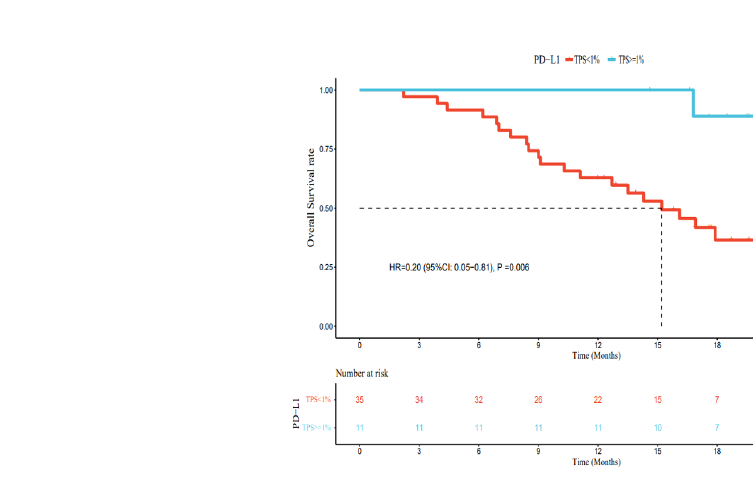
FIGURE 7 The relationship between PD-L1 expression and overall survival.